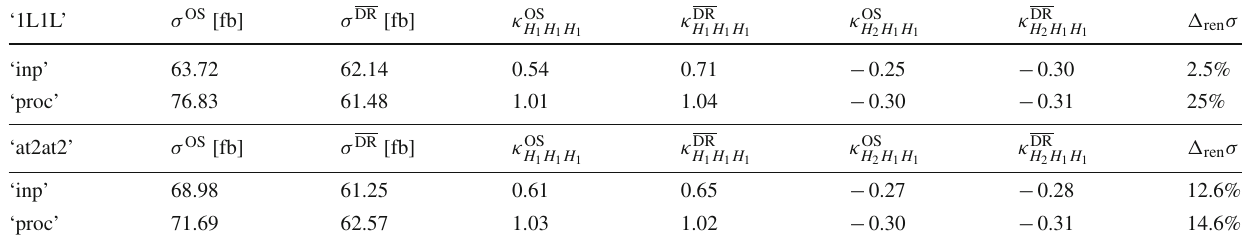
Table 4 BP10 : Cross section values for the production of a SM-like Higgs pair H 1 H 1 for OS and DR renormalisation in the top/stop sector when using loop-corrected masses and mixing angles (‘inp’) and addi- tionally loop-corrected effective trilinear Higgs self-couplings (‘proc’)